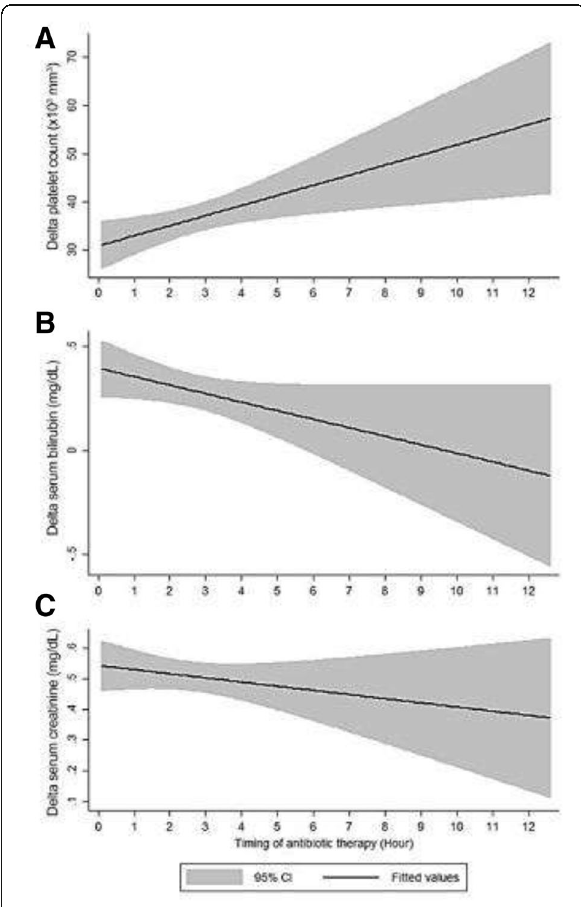
Fig. 3 (abstract 0256). Results of delta platelet, serum bilirubin, serum